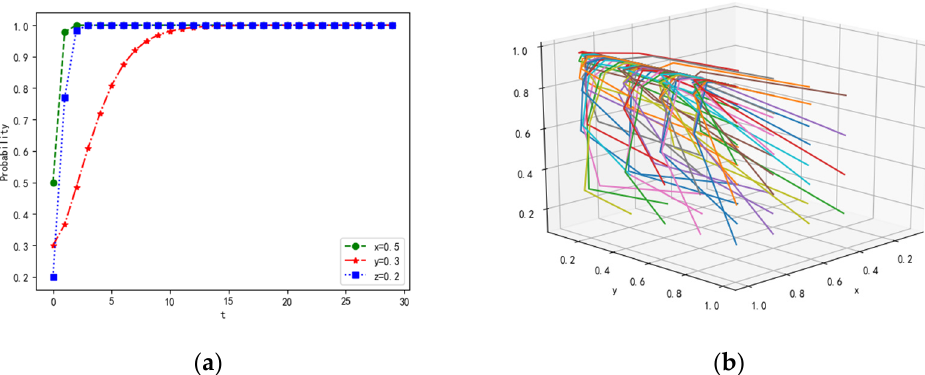
Figure 9. Evolutionary results of p 8 ( 1,1,1 ) shown under a corresponding constraint condition, ( a ) represents the conver-